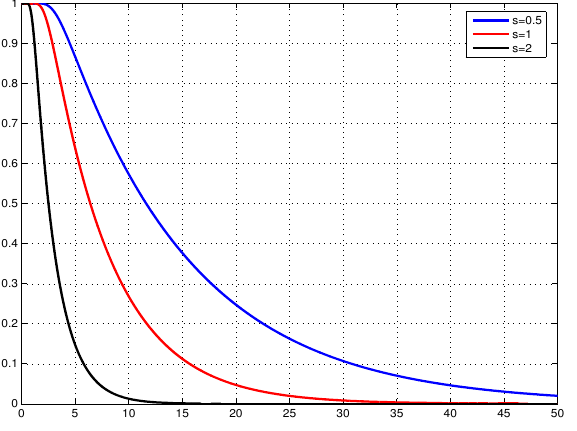
Figure 1. P ( S > t ) versus t for s =